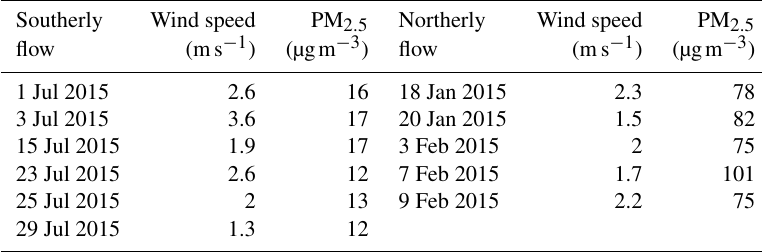
Table 3. Sampling days categorized as southerly flow and northerly flow